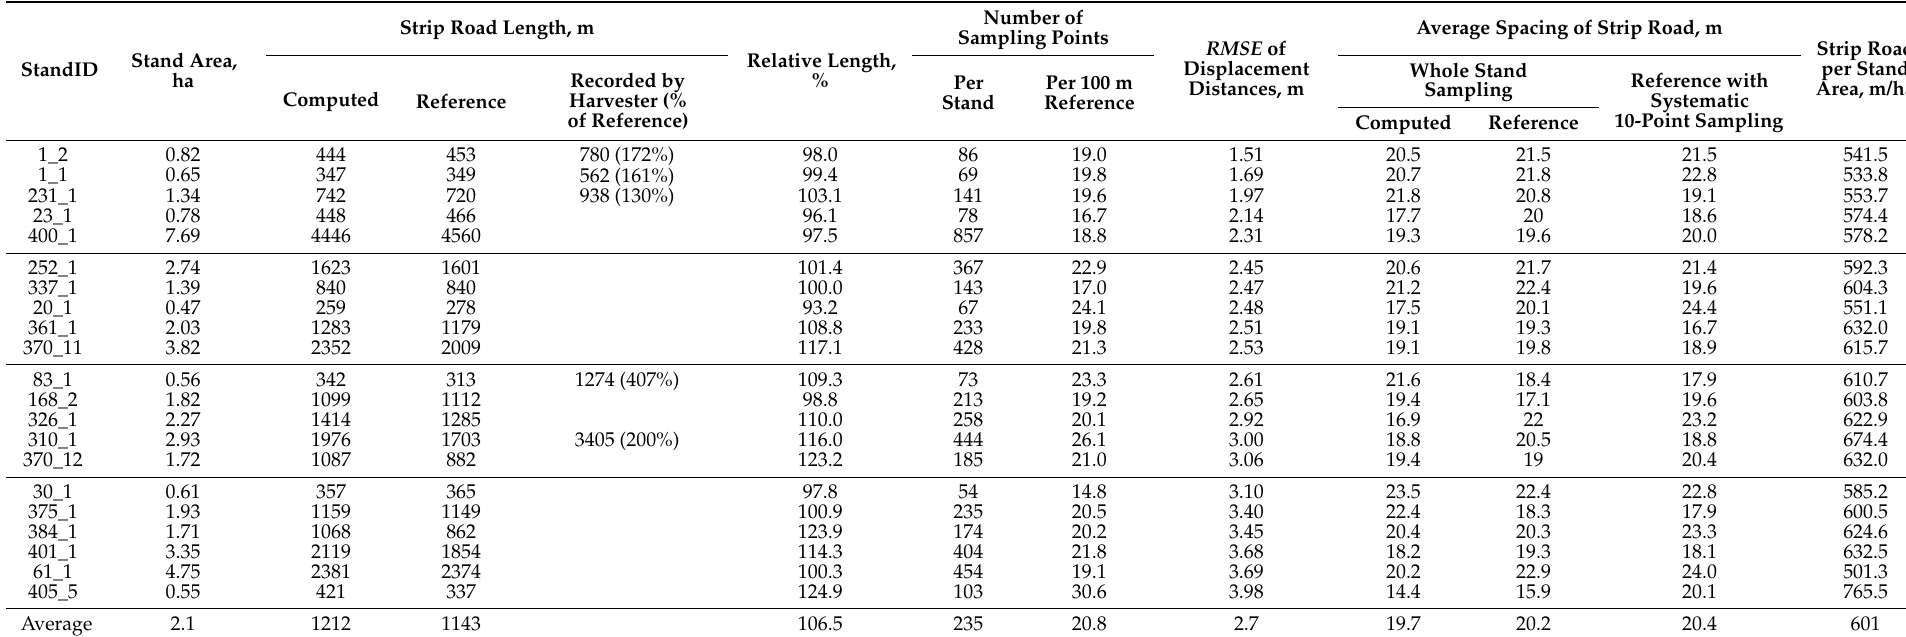
Table 2. Detailed strip road variables of the reference dataset. The number of sampling points refers to the comparison of the strip road network geometries. Note that, for the reference strip road networks, the average spacing is also sampled using the systematic quality control measurement method, in addition to sampling the whole stand. The strip road route recordings by harvester were available only for five stands; therefore, some of the values of the “Strip road length recorded by harvester, m” column are left